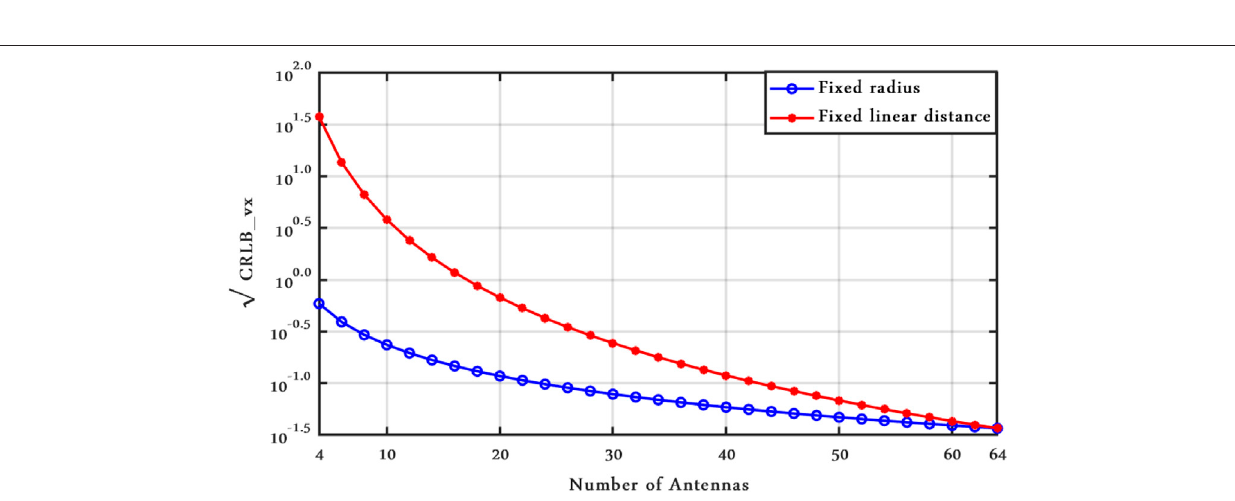
FIGURE 16 | CRLB vx vs. number of antenna, Clutter Model I with ] = 2.1, SCR = 0 dB , and v x = v y = 50